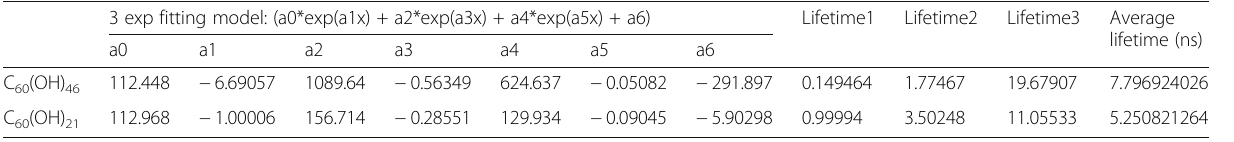
Table 4 The lifetime data and the parameter generated using a time-correlated single-photon counting technique involving a triple-exponential fitting function while monitoring the emission with 760 nm of wavelength under